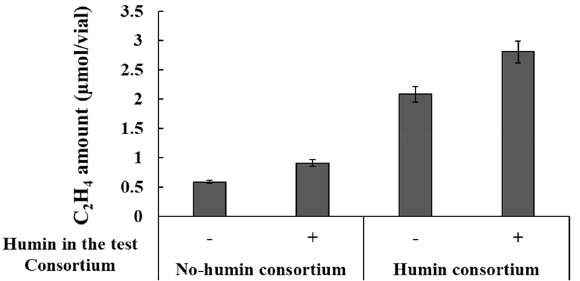
Figure 6. ARA of the no-humin and humin consortia tested in the medium supplemented with micronutrients and vitamins with (+) and without humin (−). The humin used here was Kamajima humin.